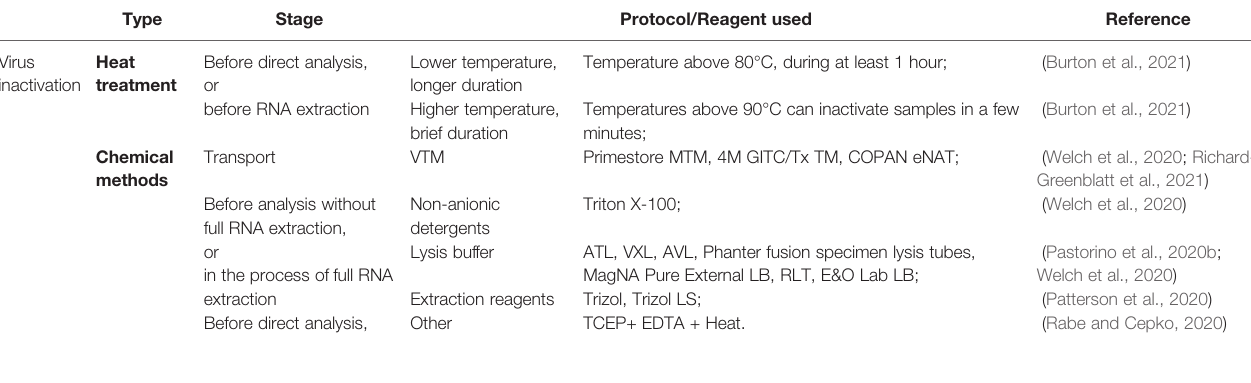
TABLE 1 | Comparison of methods used for complete inactivation of SARS-CoV-2 in clinical